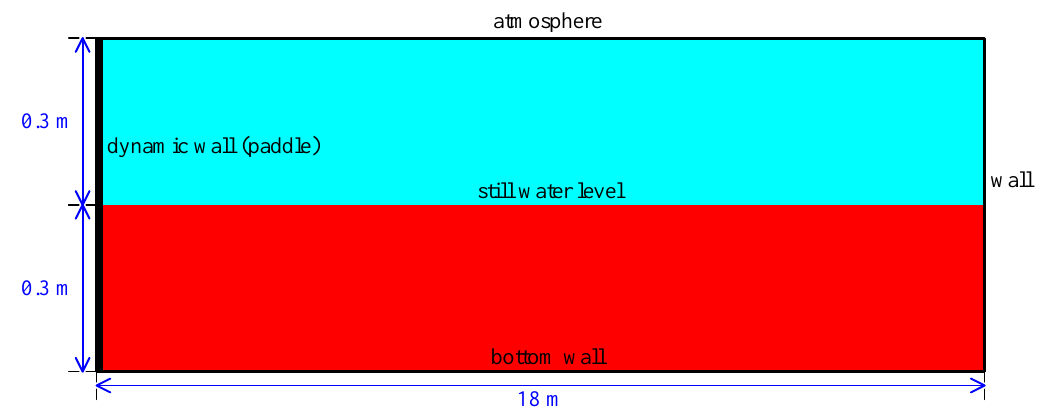
Figure 4. An illustration of the computational domain with a constant water depth.